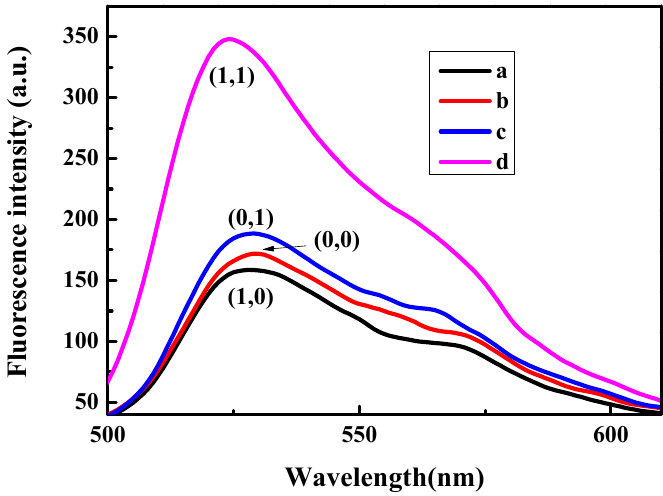
Figure 1. Fluorescence emission spectra: ( a ) DNA-T+DNA-M dsDNA, GNP and 200 µL of 10 µM ATP; ( b ) DNA-T+DNA-M dsDNA and GNP; ( c ) DNA-T+DNA-M dsDNA, GNP, and DNA-M ′ ; ( d ) DNA-T+DNA-M dsDNA, GNP, DNA-M ′ , and 200 µL of 10 µM ATP.